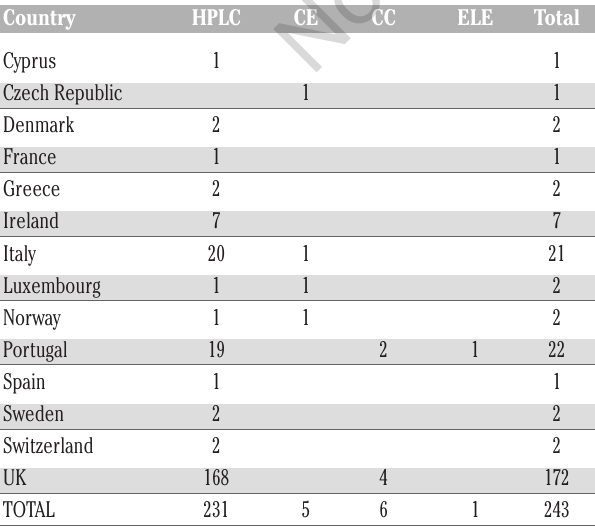
CE=Capillary Electrophoresis; CC=column chromatography; ELE=Electrophoresis and elution; HPLC=High Performance Liquid